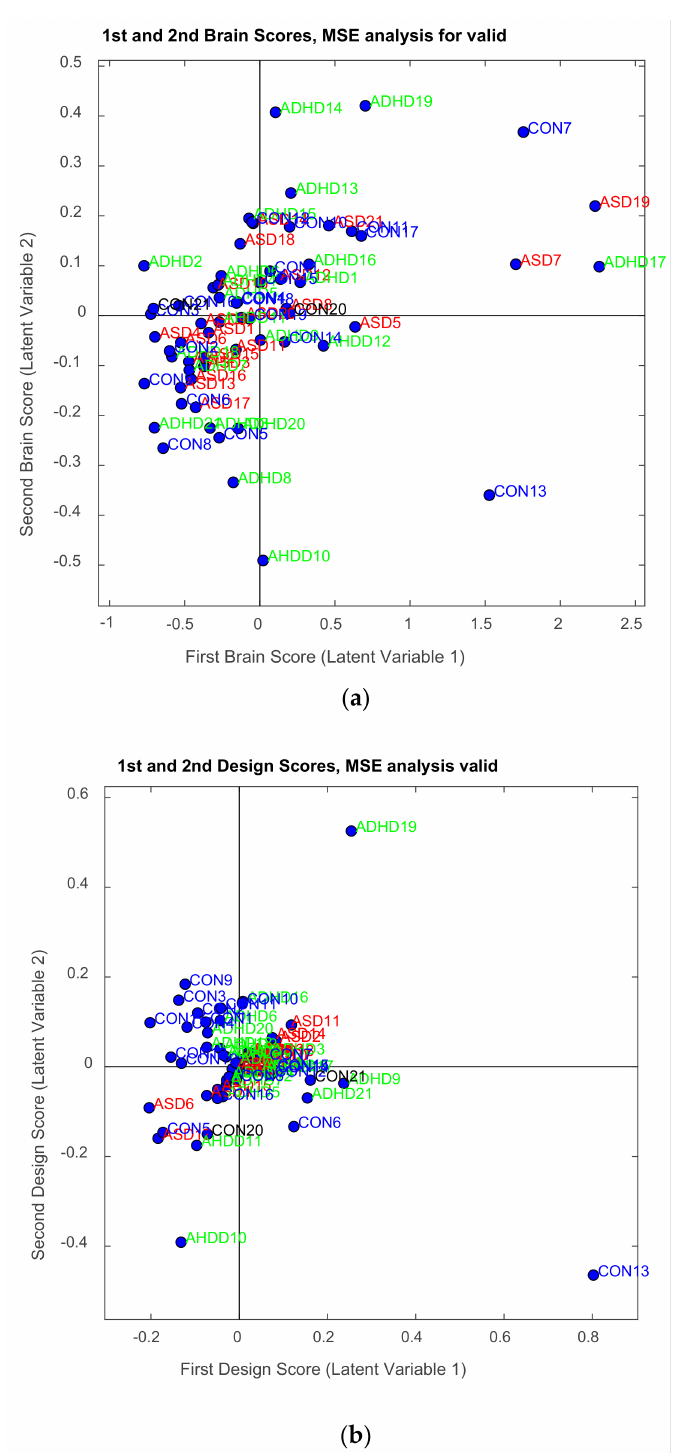
Figure 12. ( a ) Plot of first and second brain scores (latent variables), based on the average per subject MSE, for valid type of syllogism. ( b ) Plot of first and second behavior (Design) scores ( latent variables ), based on the average per subject MSE, for valid type of